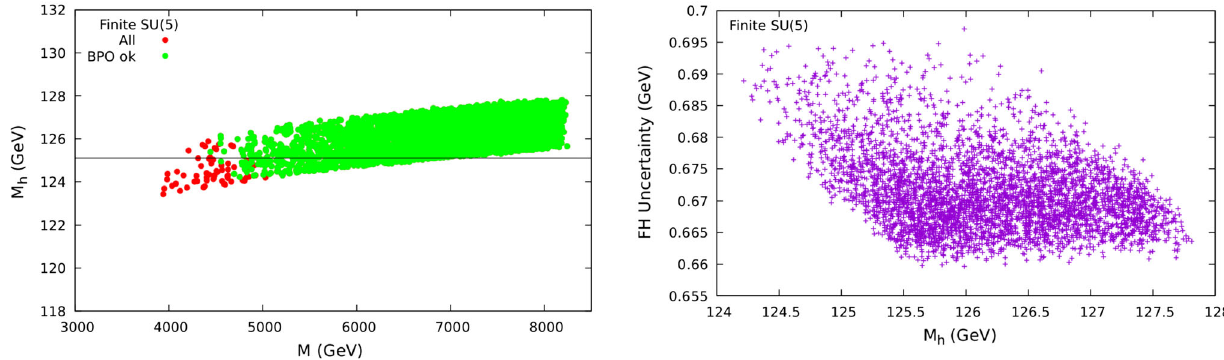
Fig. 3 Scatter plot for the finite N = 1 SU ( 5 ) model. Left: M h as a function of M . Green points comply with B -physics constraints. Right: the lightest Higgs mass theoretical uncertainty calculated with FeynHiggs 2.16.0